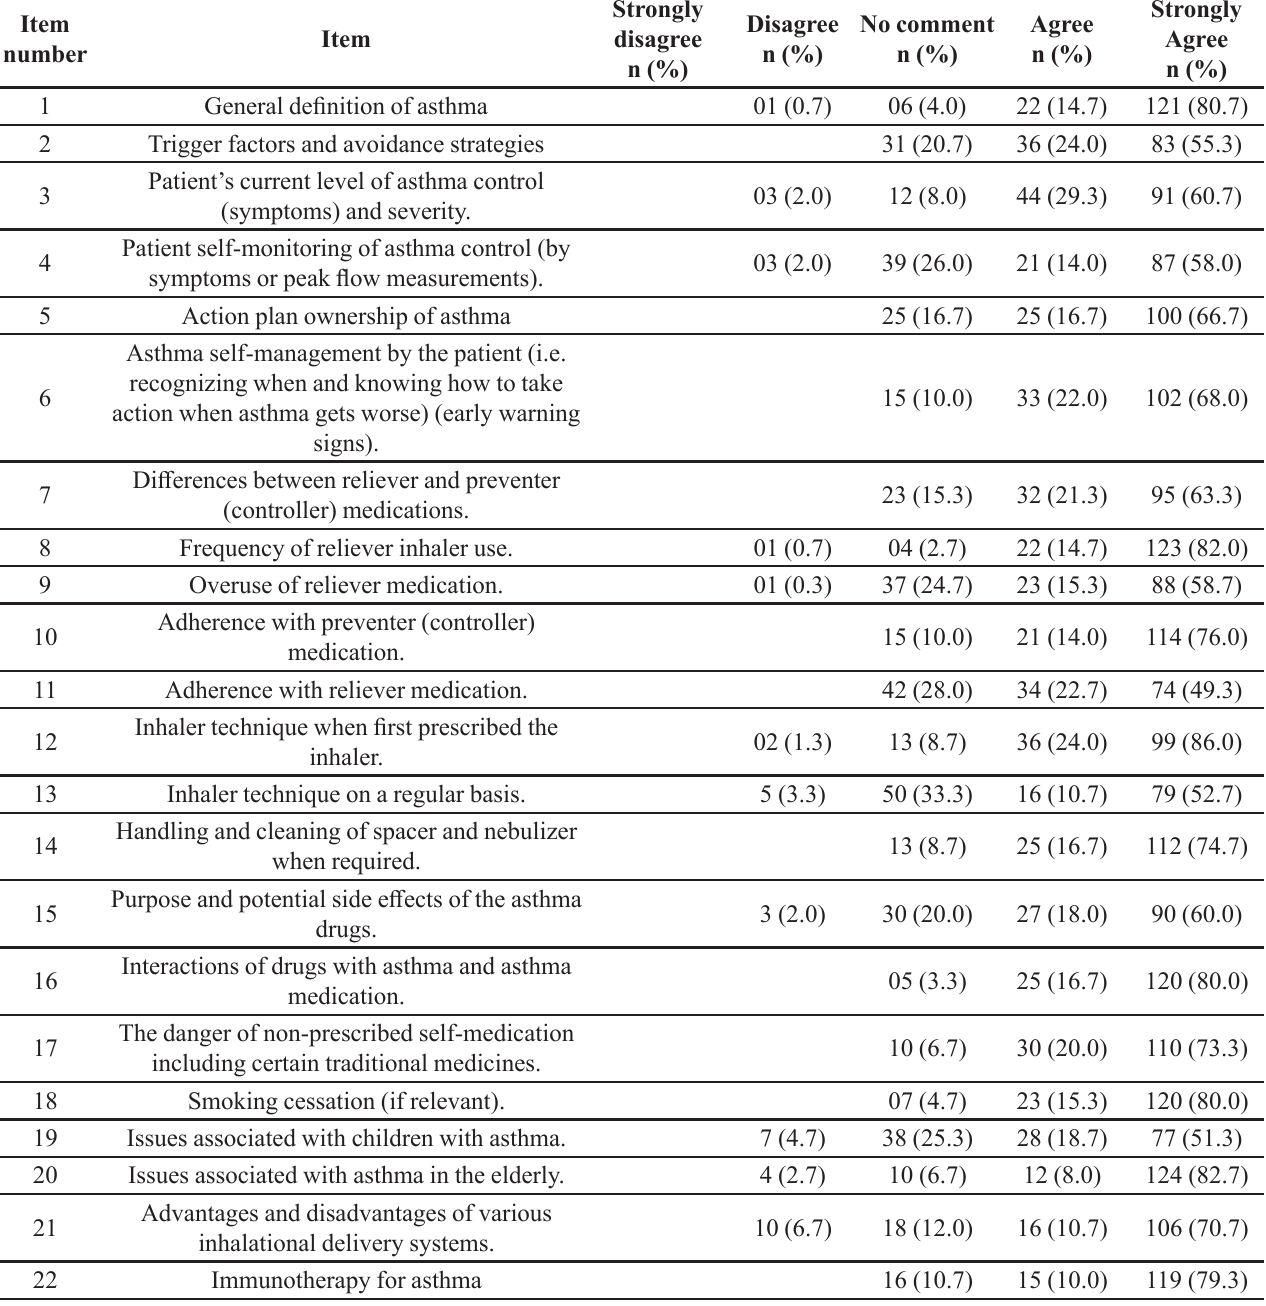
TABLE II - Perceived practice about the asthma management (n = 150) . The roles of the pharmacists should include counseling asthmatic patients